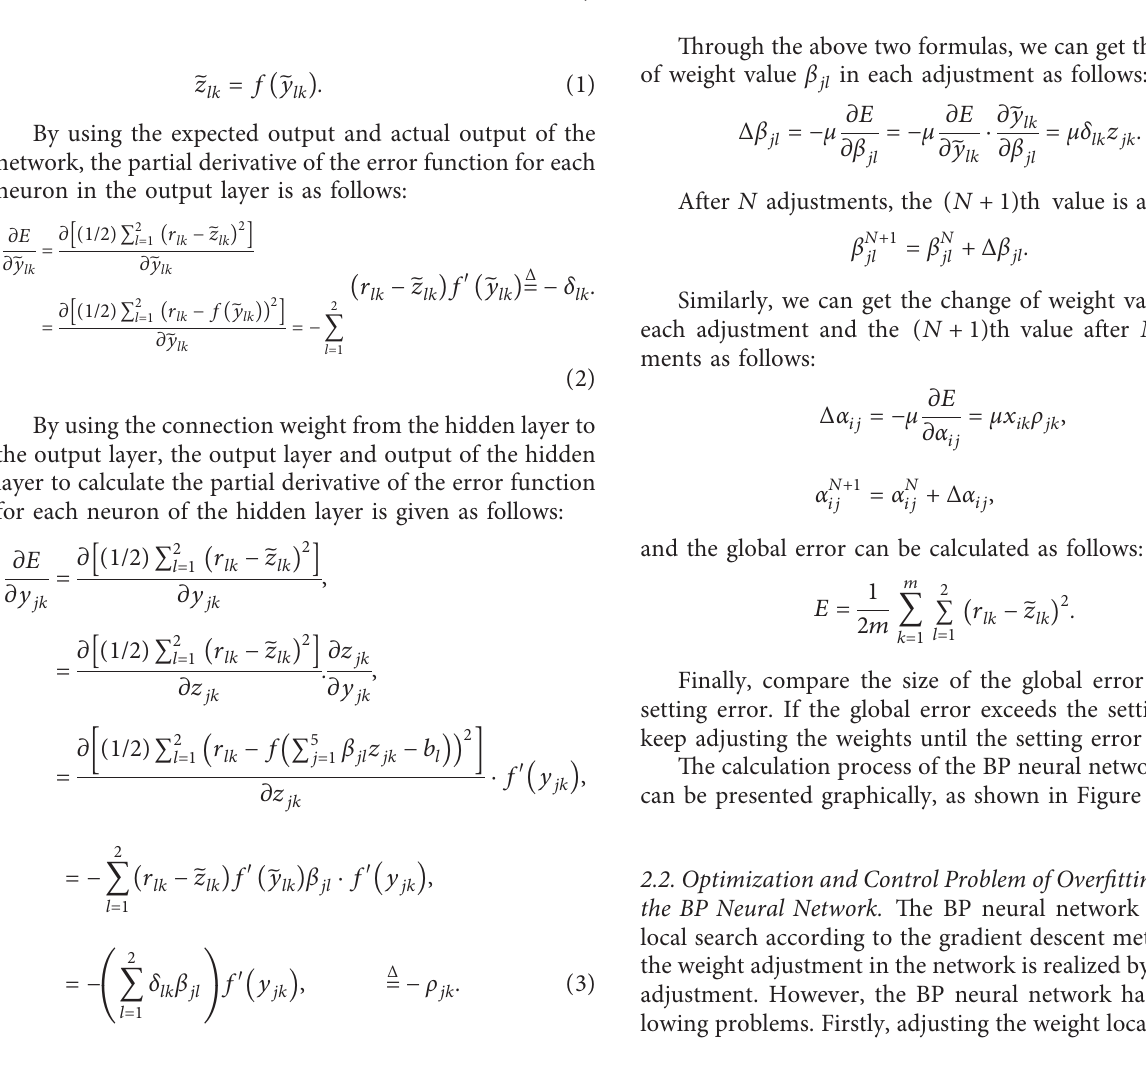
Figure 1: The three-layer BP neural network